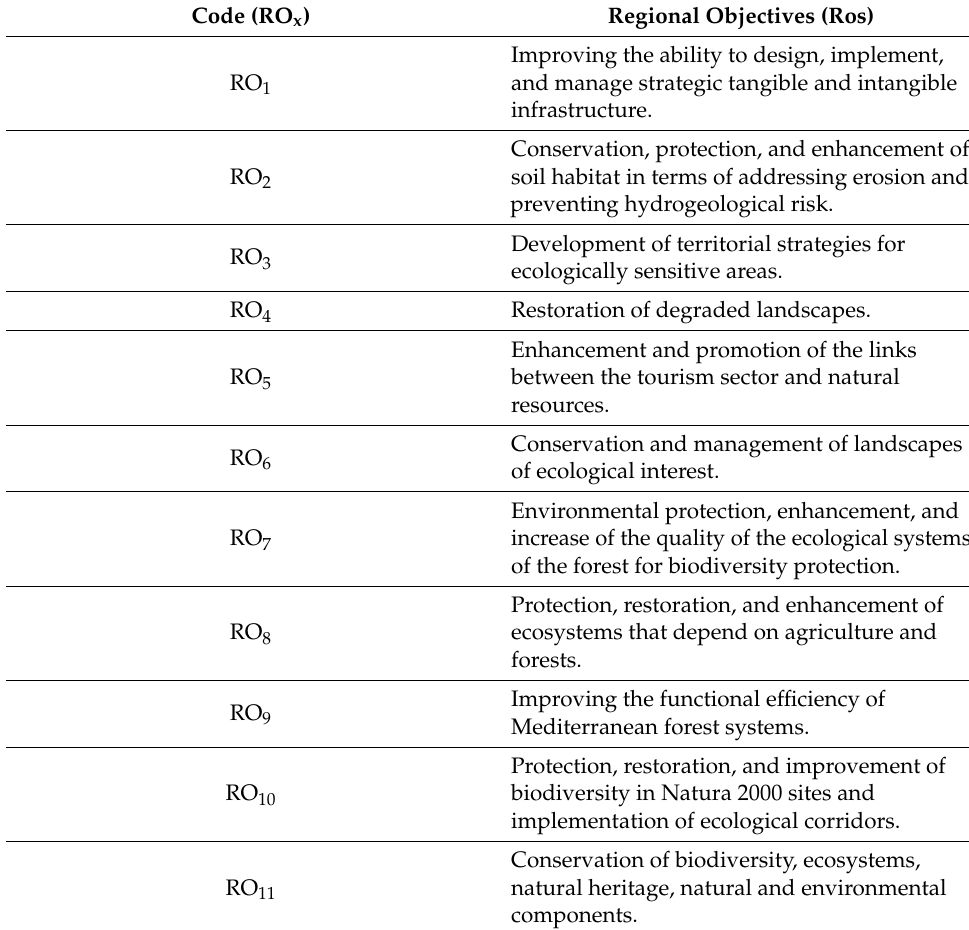
Table 4. Code and regional objectives (ROs) consistent with the 2030 Agenda, the EU Biodiversity Strategy for 2030, and the National Strategy for Sustainable Development. Code (RO x ) Regional Objectives (Ros) Improving the ability to design, implement, RO 1 and manage strategic tangible and intangible infrastructure. Conservation, protection, and enhancement of RO 2 soil habitat in terms of addressing erosion and preventing hydrogeological risk. Development of territorial strategies for RO 3 ecologically sensitive areas. RO 4 Restoration of degraded